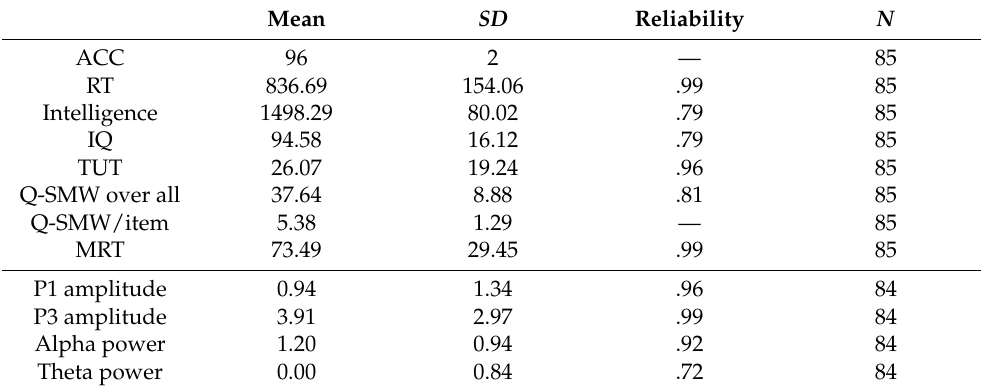
Table 1. Descriptive statistics of all variables.